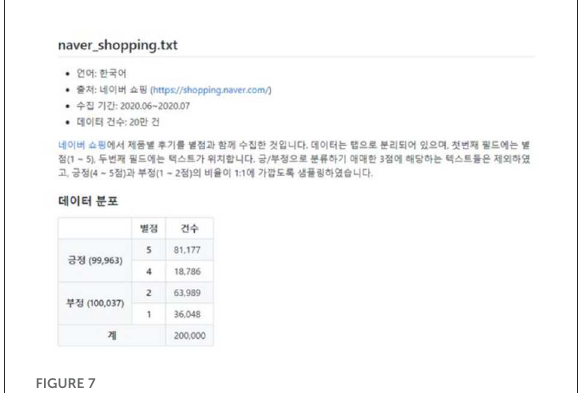
FIGURE7 Naver shopping mall comment dataset.